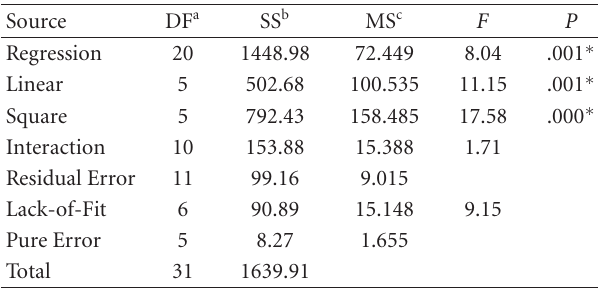
Table 9: Analysis of variance for the quadratic model.